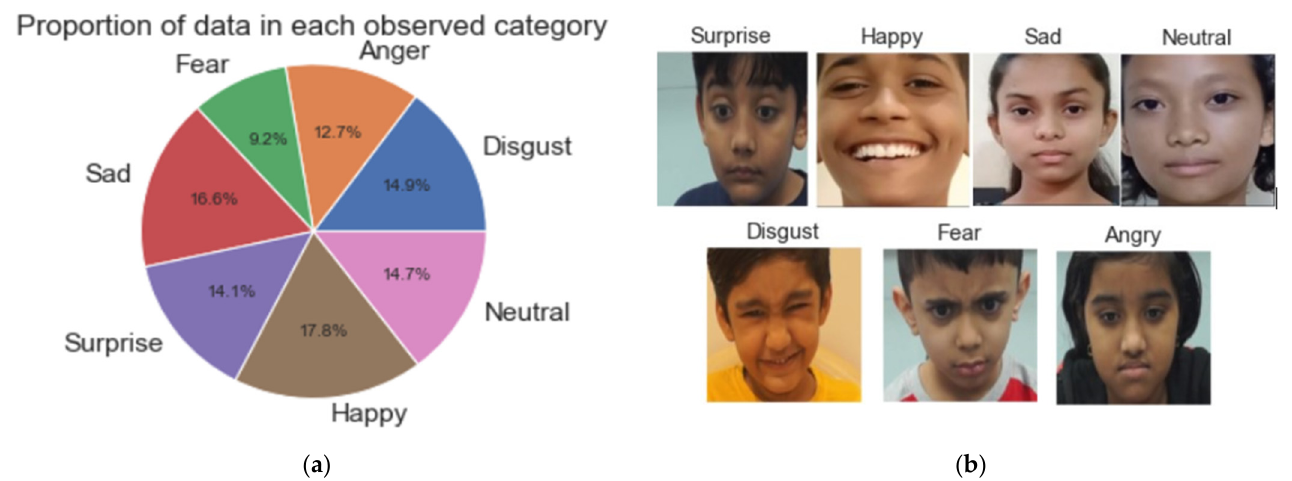
Figure 4. ( a ) Authors' emotion database distribution. ( b ) Sample video frame images captured from authors' emotions database.